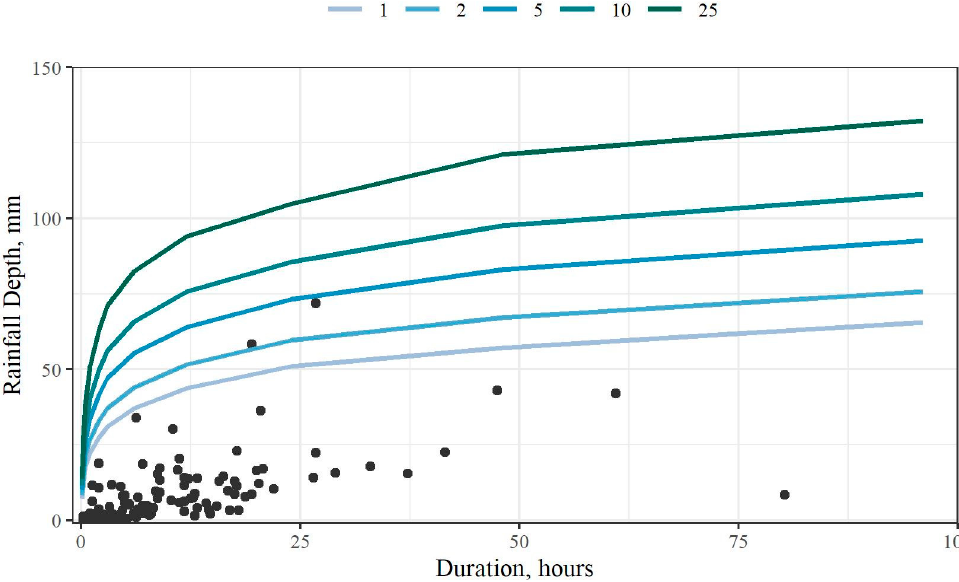
Figure 5. Rainfall duration and depth with recurrence intervals in years for Syracuse, New York. Recurrence intervals are based on historic data measured between 1950 and 2008 for the region [28].